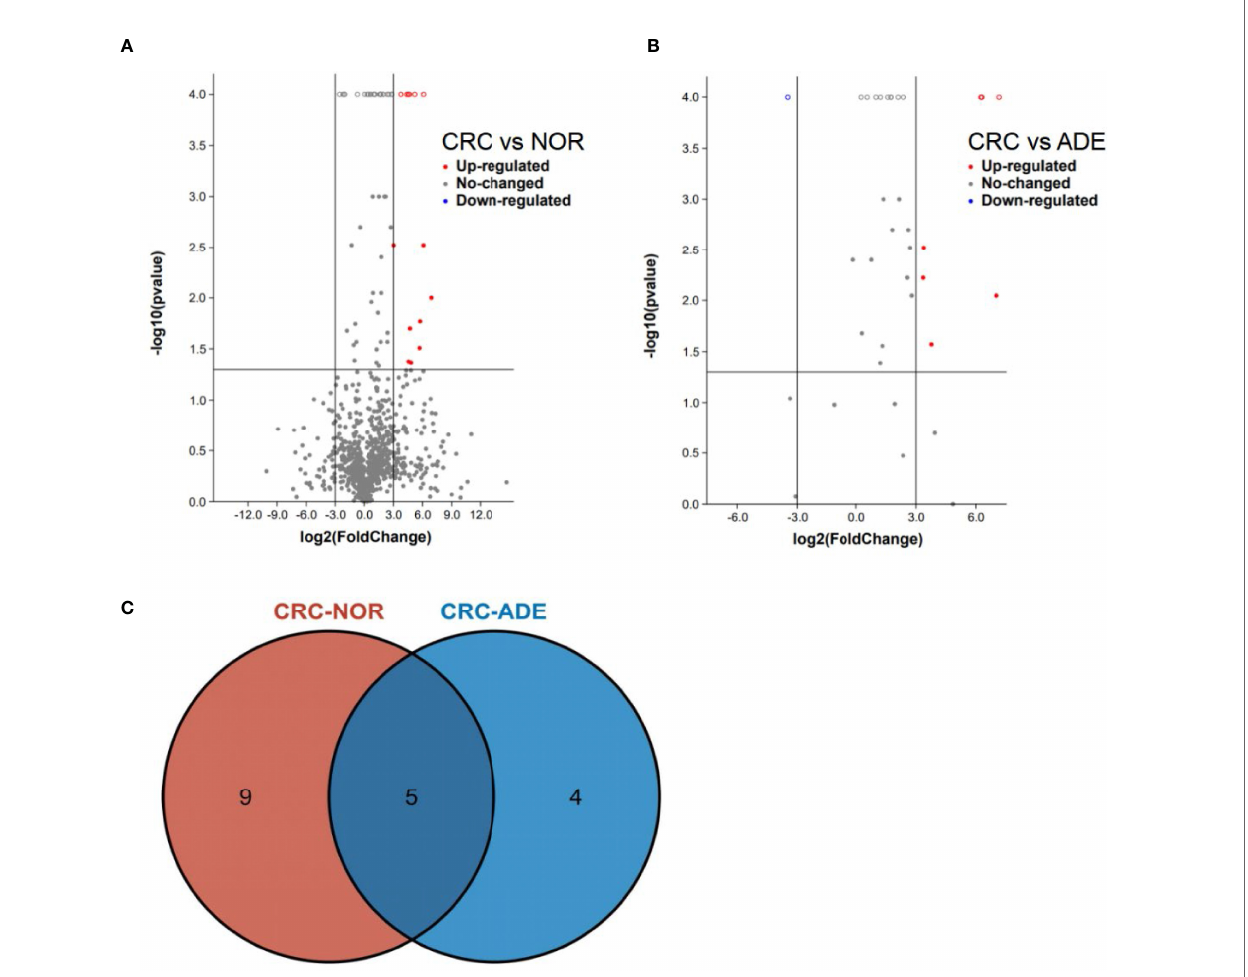
FIGURE 1 | gutMEGA database analysis. (A) The volcano chart shows that the species level of colorectal cancer is compared with the normal human intestinal fl ora, and the species level meets the conditions of Log2(colorectal cancer/NOR) > 3, P < 0.05. (B) The volcano chart shows that the species level of colorectal cancer patients meets the conditions of Log2(colorectal cancer/ADE) > 3, P < 0.05 compared with those with adenoma. (C) The Venn diagram shows the analysis results of the gutMEGA database. ADE, adenoma; NOR, normal